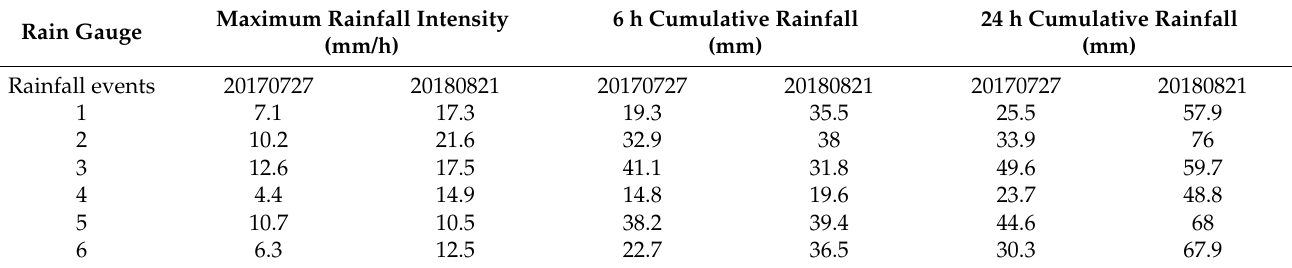
Table 1. The statistical values of the two observed rainstorms.